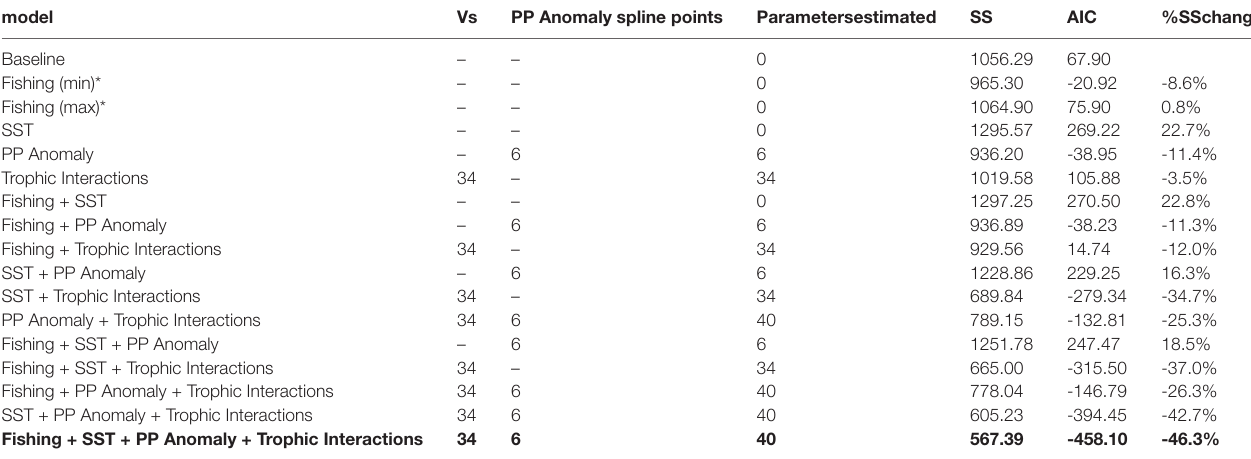
TABLE 3 | Description, Sum of Squares (SS) and Akaike Information Criterion (AIC) of selected steps of the stepwise fitting. model Vs PP Anomaly spline